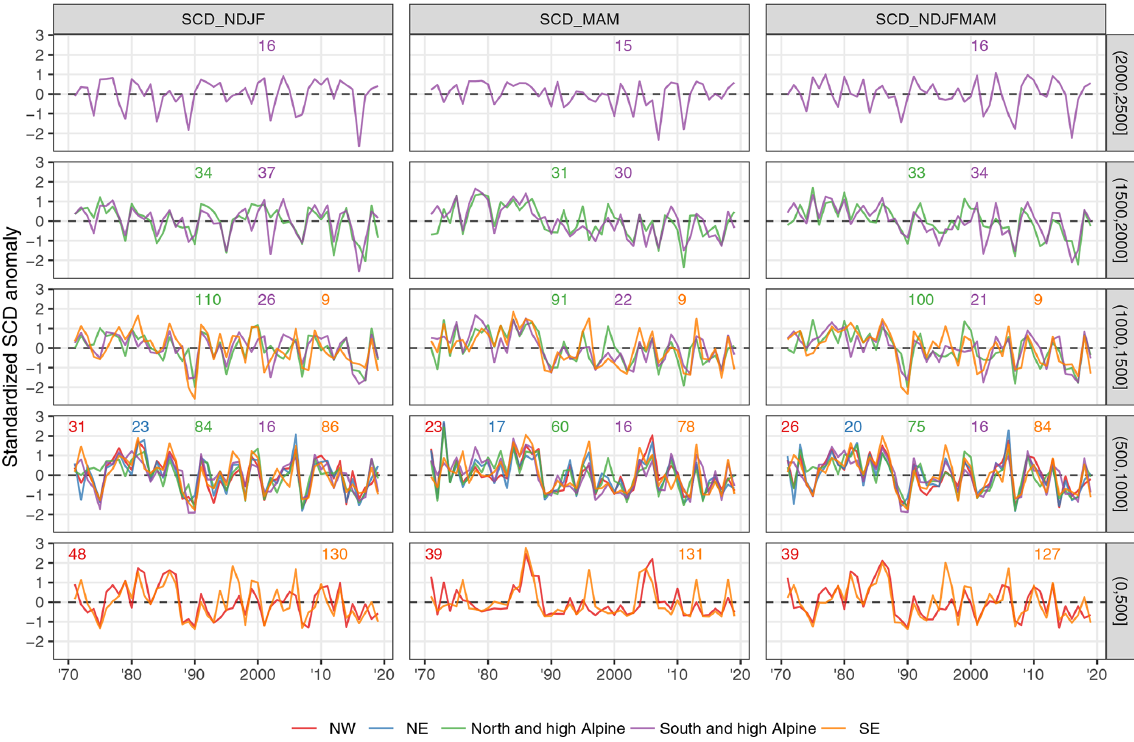
Figure C6. Same as Fig. C5 but for standardized